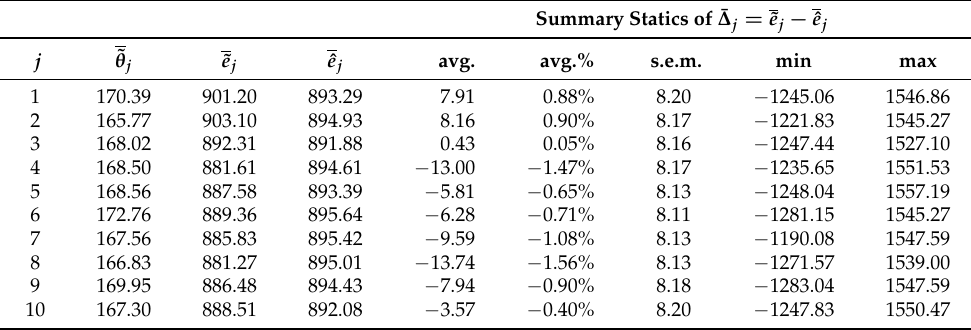
Table 4. Results by DoC event from N = 10,000 simulations ( N c = 9472) generated by Arm B